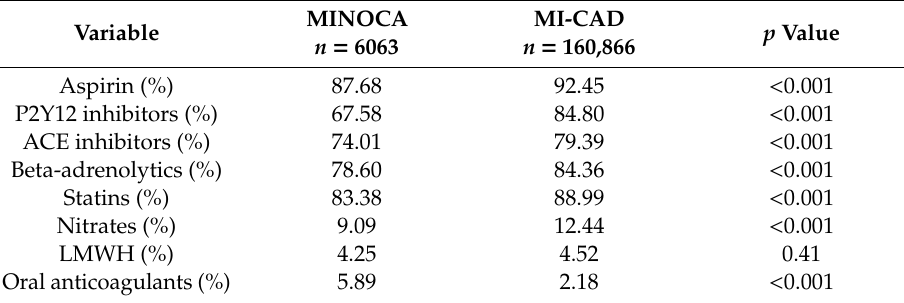
Table 3. Medications at discharge.